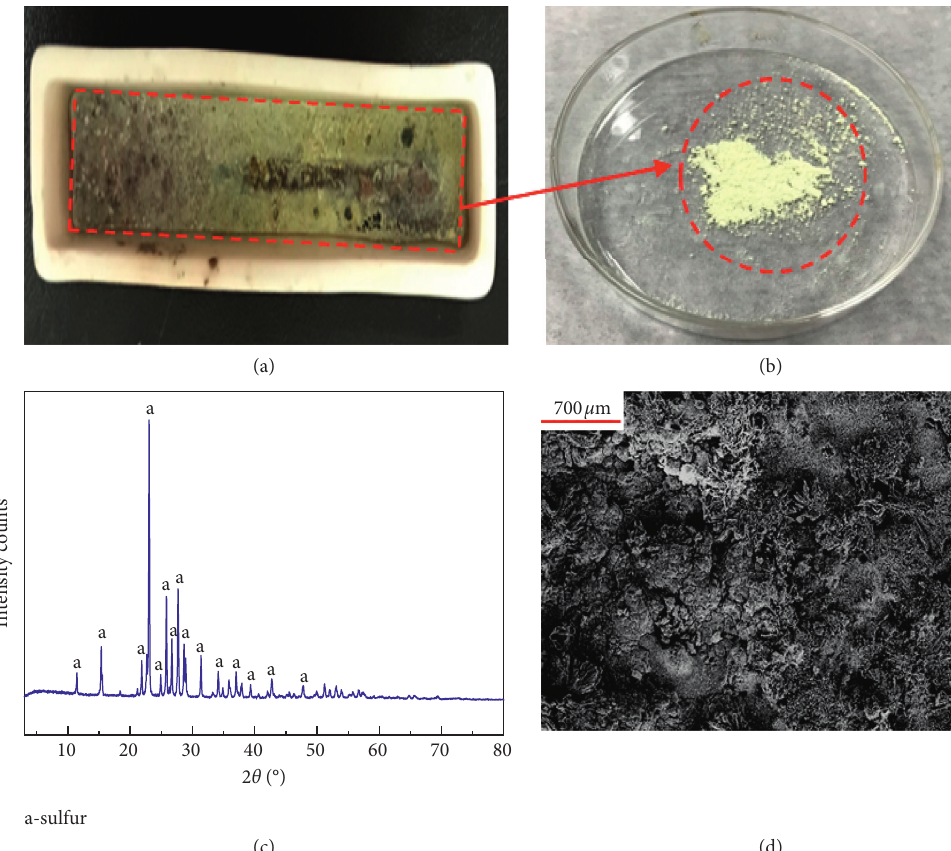
Figure 11: The photo of the (a) overall sample and (b) topmost sample roasted under anoxic conditions at 1200 ° C for 40min; (c) the XRD patterns and (d) SEM image of the top layer of the sample